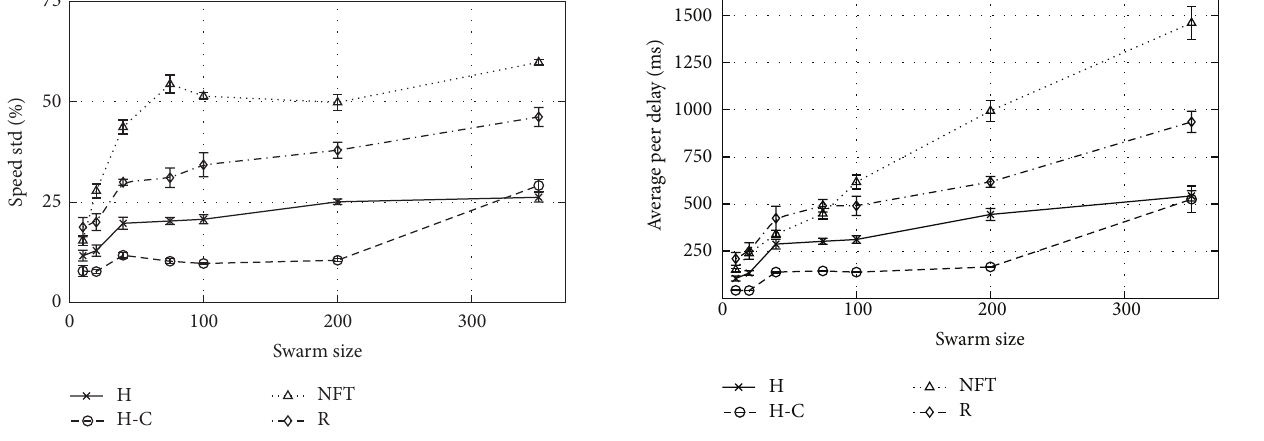
Figure 9: Average peer speed fluctuations in Scenario I.